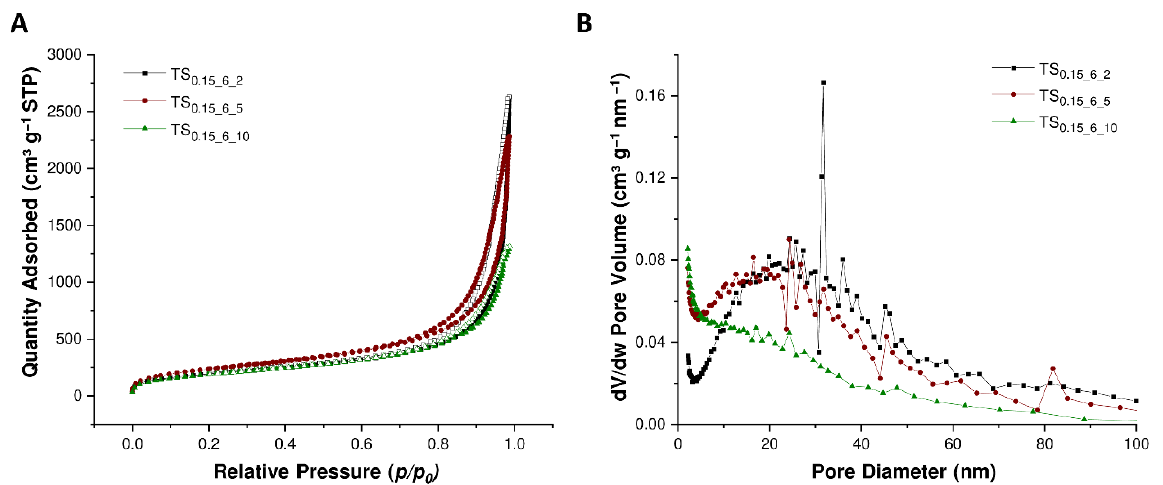
Figure 7. Nitrogen adsorption (full symbols) and desorption (empty symbols) isotherms ( A ) and the pore size distribution ( B ) of TS 0 . 15_6_2 (black), TS 0 . 15_6_5 (green) and TS 0 . 15_6_10 (red).